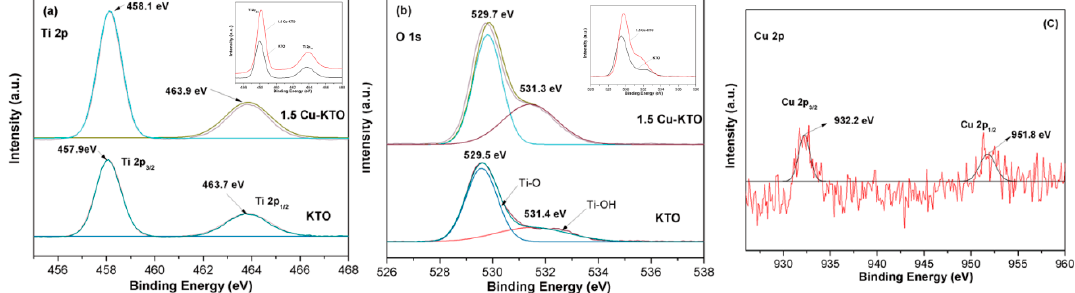
Figure 2. XPS spectra of Ti 2p for KTO and 1.5 Cu–KTO ( a ), O 1s for KTO and 1.5 Cu–KTO ( b ), and Cu 2p for 1.5 Cu–KTO ( c ).